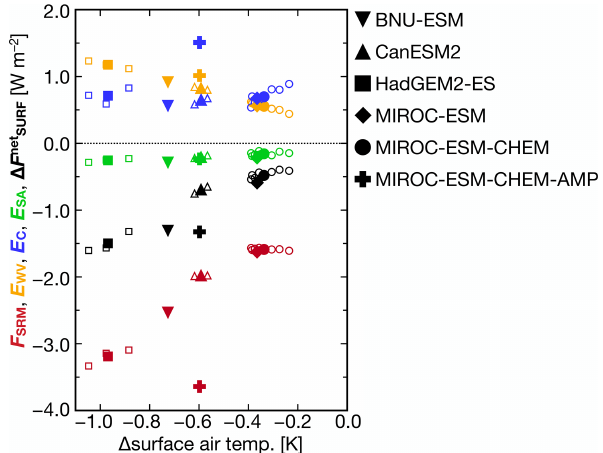
Figure 5. Same as Fig. 3 but also for SRM forcing (red), SW total reactions due to changes in the water vapour amount (orange), cloud amount (blue), and surface albedo